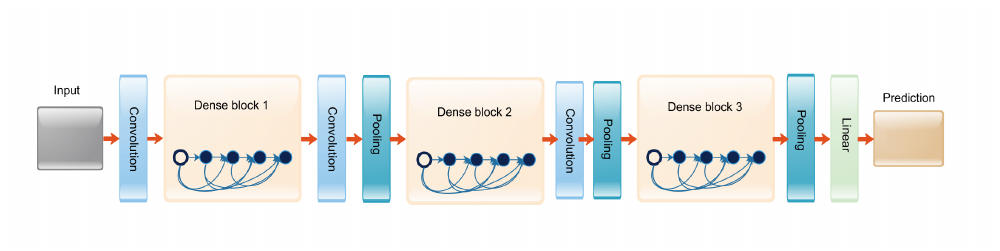
Figure 7. Classification based on Densely Connected Convolutional Network (DenseNet)